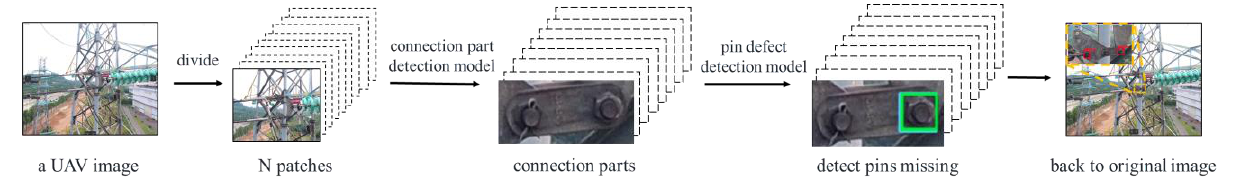
Figure 1 . Pipeline of the cascade pin defect detection.